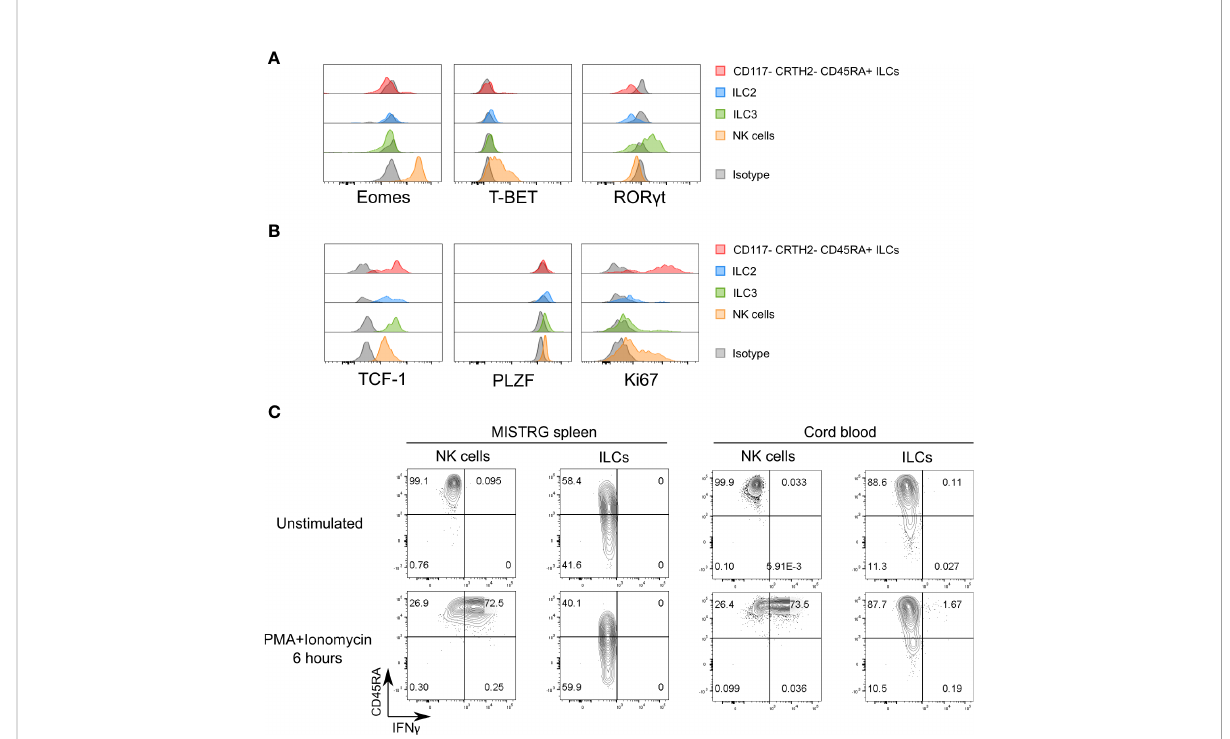
FIGURE 4 Proliferative CD117 - CRTH2 - CD45RA + ILCs express the transcription factor TCF-1. (A) Intracellular expression of signature transcription factors (Eomes, T-BET, ROR g t) in human CD117 - CRTH2 - CD45RA + ILCs, CRTH2 + ILC2s, CD117 + CRTH2 - ILC3s, and NK cells isolated from the spleen of HSPC-engrafted MISTRG mice (n = 5). Matched isotype antibodies were used as controls. (B) Intracellular expression of transcription factors (TCF-1, PLZF) and Ki67 in human CD117 - CRTH2 - CD45RA + ILCs, CRTH2 + ILC2s, CD117 + CRTH2 - ILC3s, and NK cells isolated from the spleen of HSPC-engrafted MISTRG mice (n = 6). Matched isotype antibodies were used as controls. (C) Intracellular IFN g expression by human ILCs and NK cells in the spleen of HSPC-engrafted MISTRG mice and in umbilical cord blood (n = 4). Cells were either unstimulated or stimulated with PMA and ionomycin for 6 hours. ILCs were gated as human CD45 + CD127 + CD94 - CD3 - TCR ab - Lin - cells and NK cells were gated as human CD45 + CD127 - CD94 + CD3 - TCR ab - Lin - cells as in Supplementary Figure 1. ILC subsets and NK cells were also gated as CD34 - cells. Data represent mean ± SEM and are representative of two (B, C) or three (A) independent